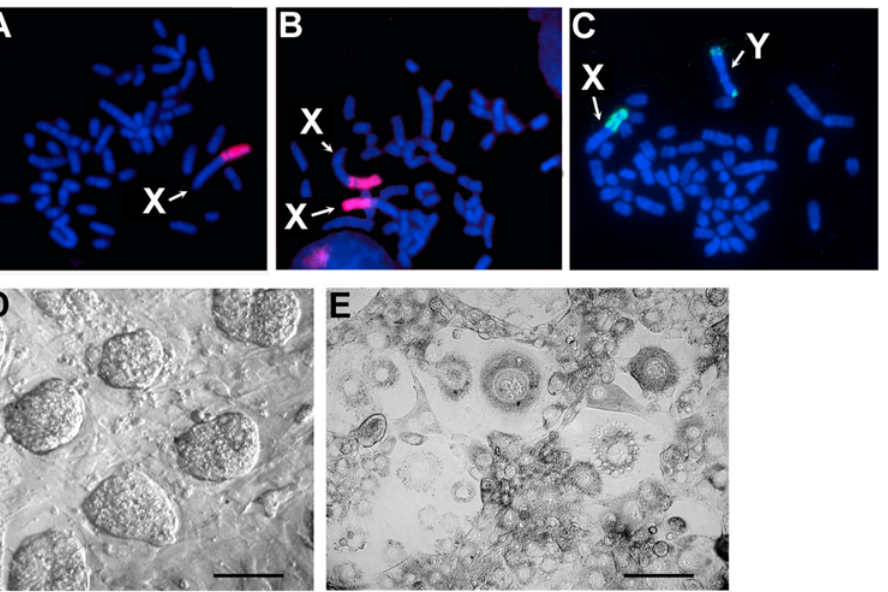
Figure 2. Characterisation of M.rossiaemeridionalis TS-like cell lines. Fluorescent in situ hybridization (FISH) of vole sex chromosome specific heterochromatin repeats MS4 (red and green) on metaphase chromosomes obtained from three TS-like cell lines with the sex chromosome compositions: X0 ( A ), XX ( B ), and XY ( C ). Chromosomes are counterstained with DAPI. Morphology of undifferentiated vole TS-like cell colonies grown on a feeder layer of embryonic fibroblasts ( D ) and giant trophoblast cells obtained by spontaneous differentiation of TS-like cells at the 28 th passage ( E ). The scale bar represents 200 m m in ( D and E ).